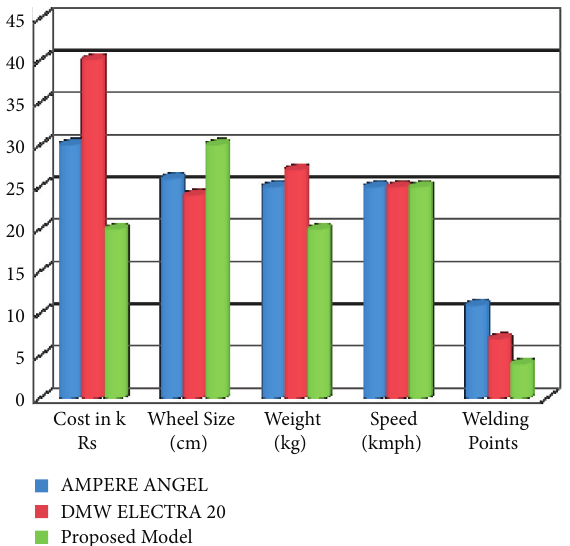
Figure 11: Comprehensive graphical analysis of the proposed E-Bike and existing E-Bike